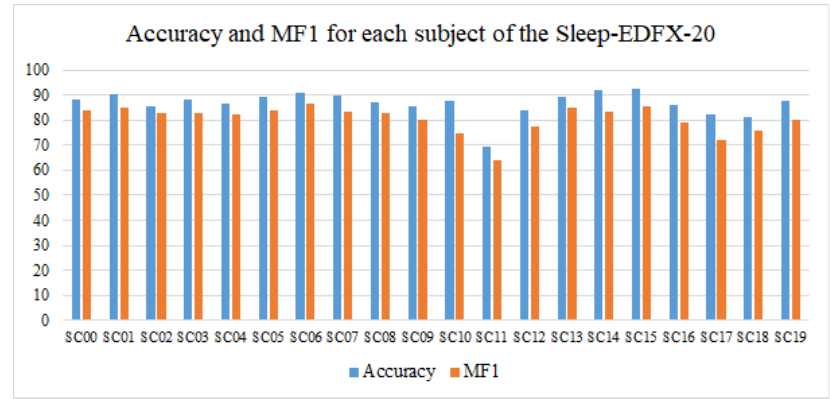
Table 4. Confusion matrix of Sleep-EDFX-20 dataset.